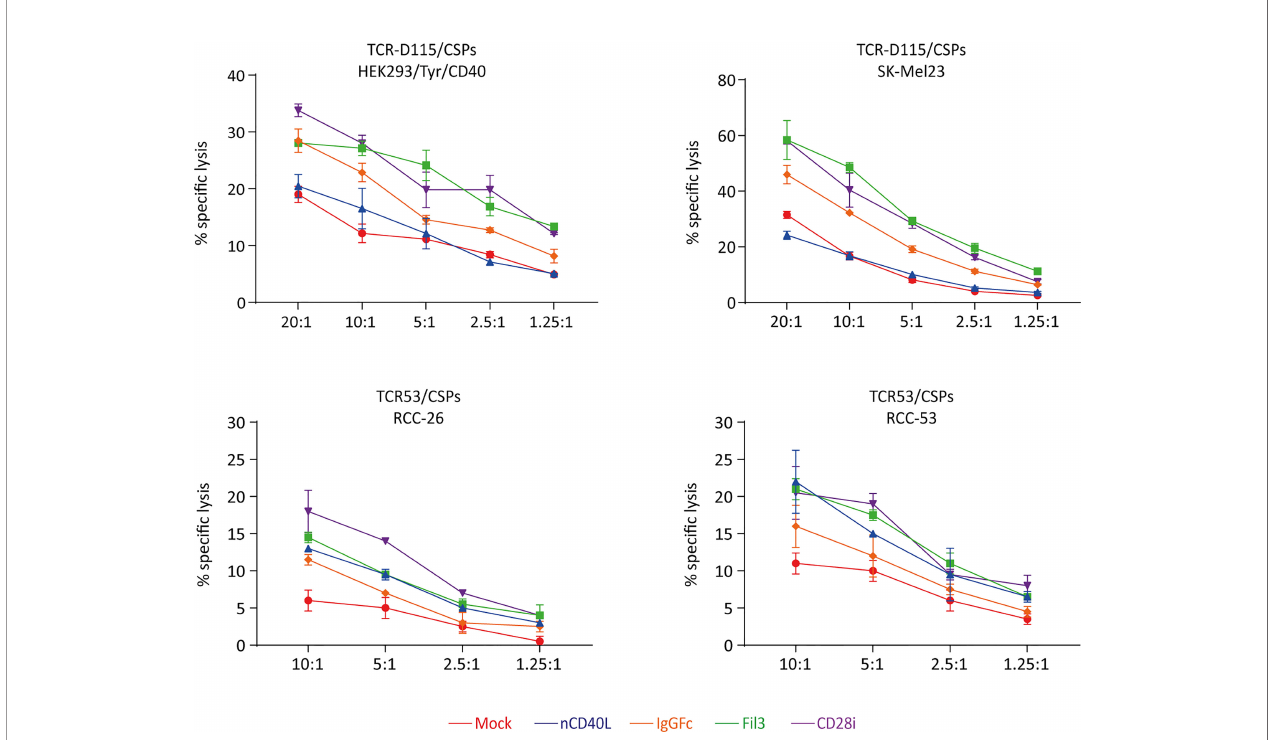
FIGURE 11 | CD40L:CD28 CSPs improve cytolytic activity of antigen-speci fi c T cells. TCR-D115 tyrosinase-speci fi c T cells and TCR53 RCC-speci fi c T cells expressing the CD40L:CD28 CSPs were thawed and used immediately without re-activation in a 4h chromium release assay at indicated T cell to target cell ratio with tyrosinase-positive target cells SK-Mel23 and HEK293/Tyr/CD40 for TCR-D115 T cells, and RCC-26 and RCC-53 RCC tumor cell lines for TCR53 T cells. Shown are mean values of duplicates from one representative experiment. Error bars show the standard deviation. All target cells expressed CD40 and HLA-A2 (see histograms Figures 6 , 10